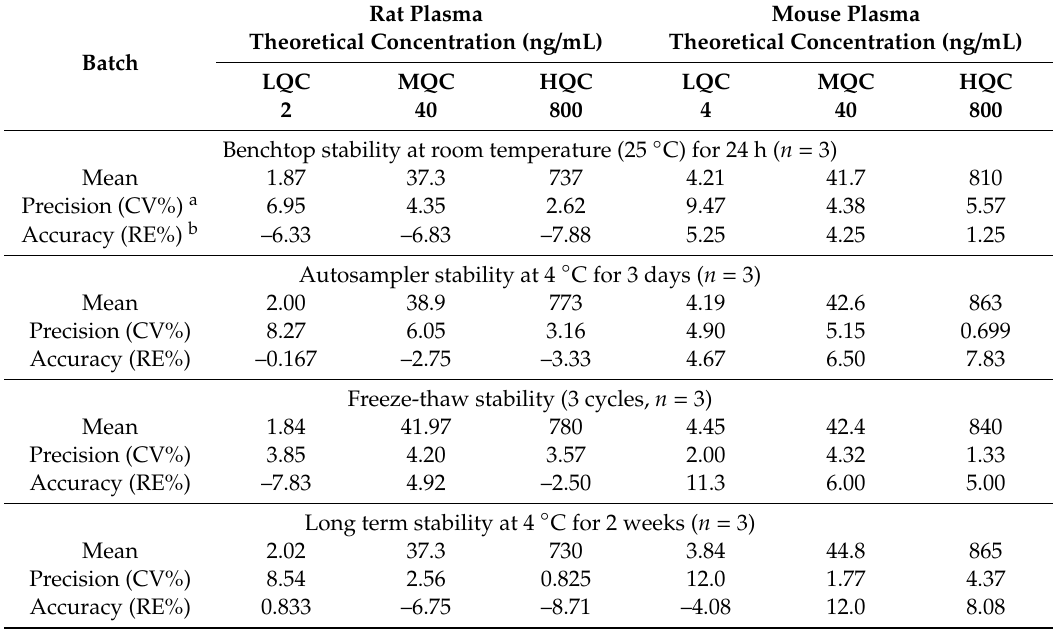
Table 6. Stability of SH-1242 QC samples under typical storage